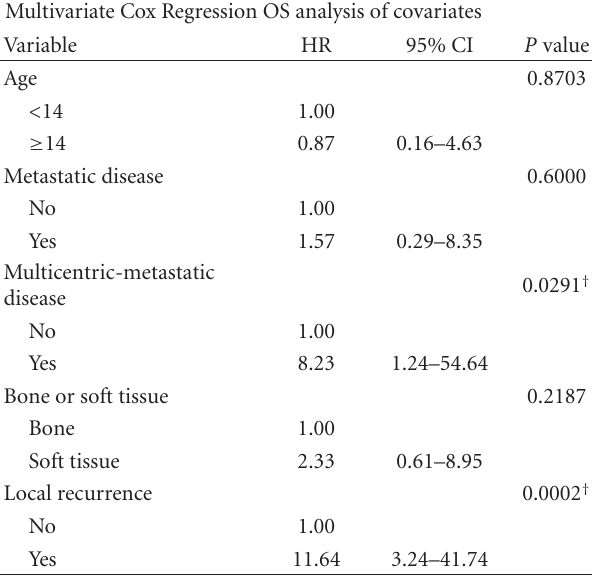
Table 9: Determination of independent variables for Overall Sur- vival (OS) with multivariate Cox regression